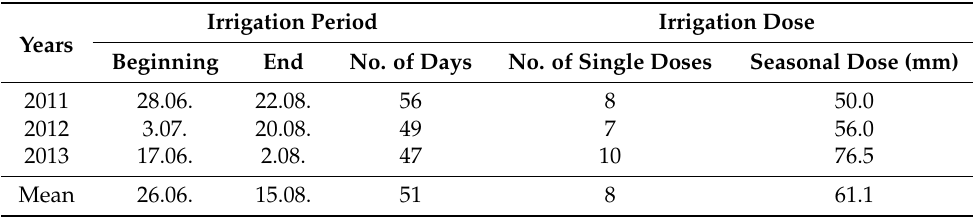
Table 5. Characteristics of irrigation periods of potato in particular growing seasons.